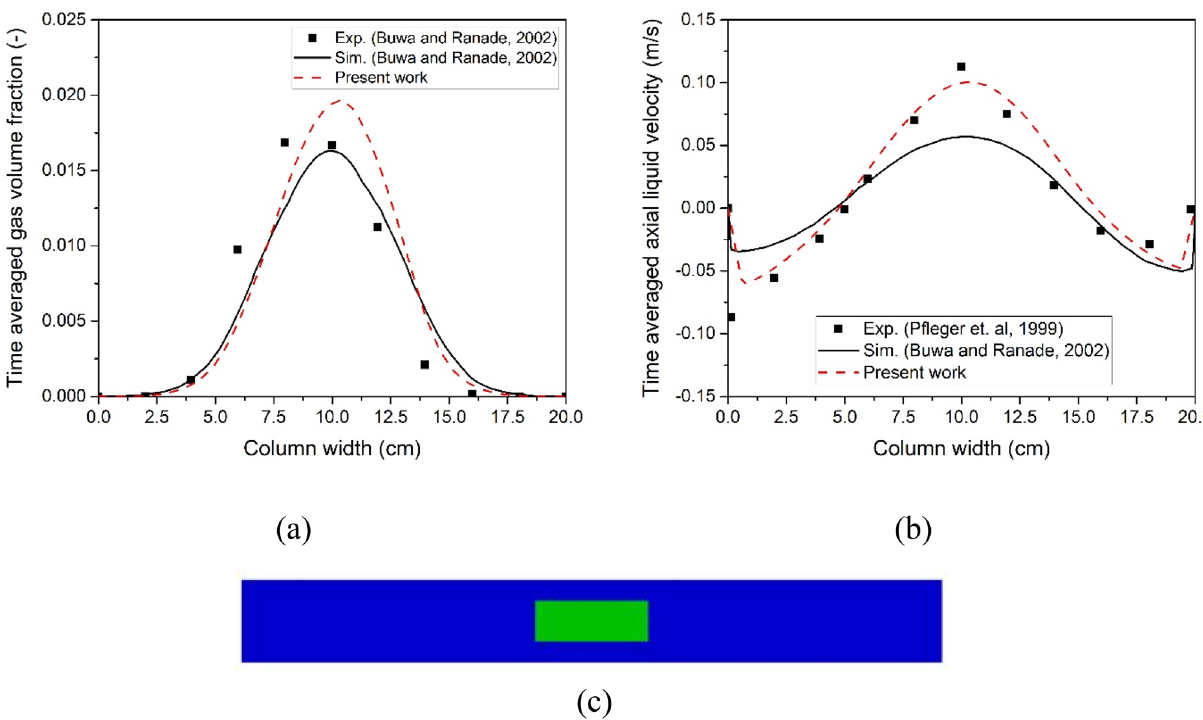
Fig. 4 Comparison of two-fluid time-averaged a gas volume fraction distribution, b vertical liquid velocity and c sparger configuration at superficial gas velocity 0.14 cm/s (H/W = 2.25, Y = 37